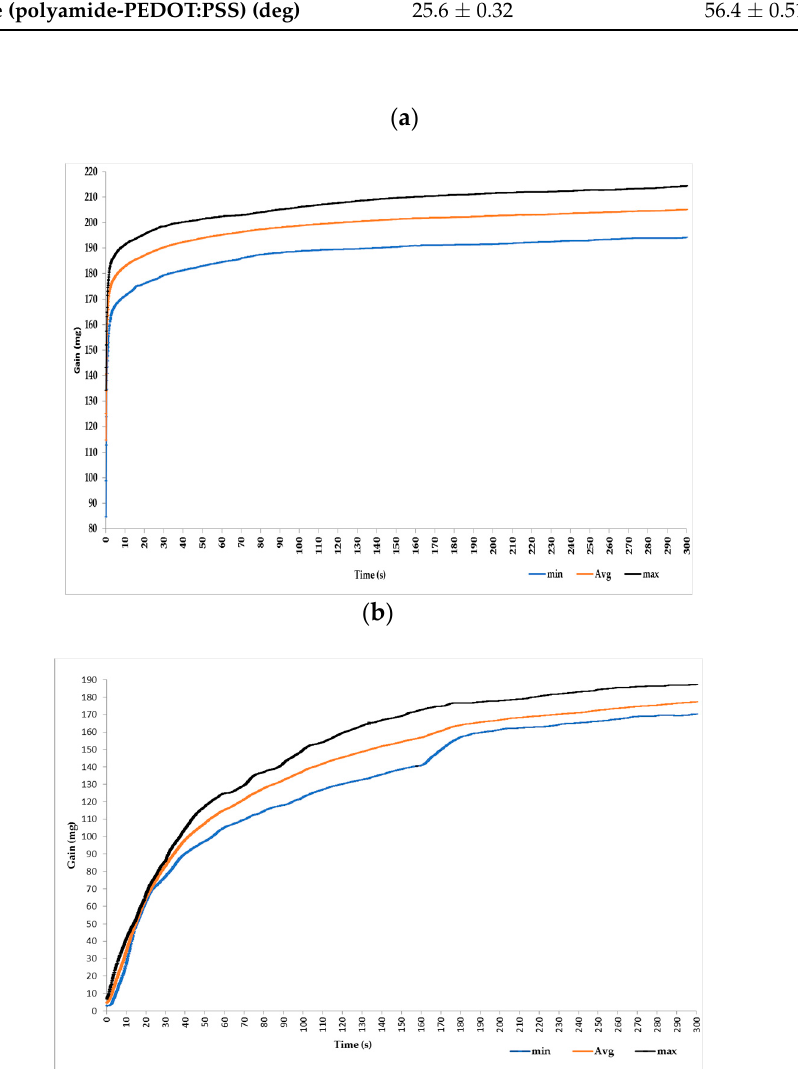
Figure 8 . Weight of PEDOT:PSS absorbed by polyamide textile fabric during 300 seconds. ( a ) by using Figure 8. Weight of PEDOT:PSS absorbed by polyamide textile fabric during 300 s. ( a ) by using S1; S1); ( b ) by using S2. ( b ) by using